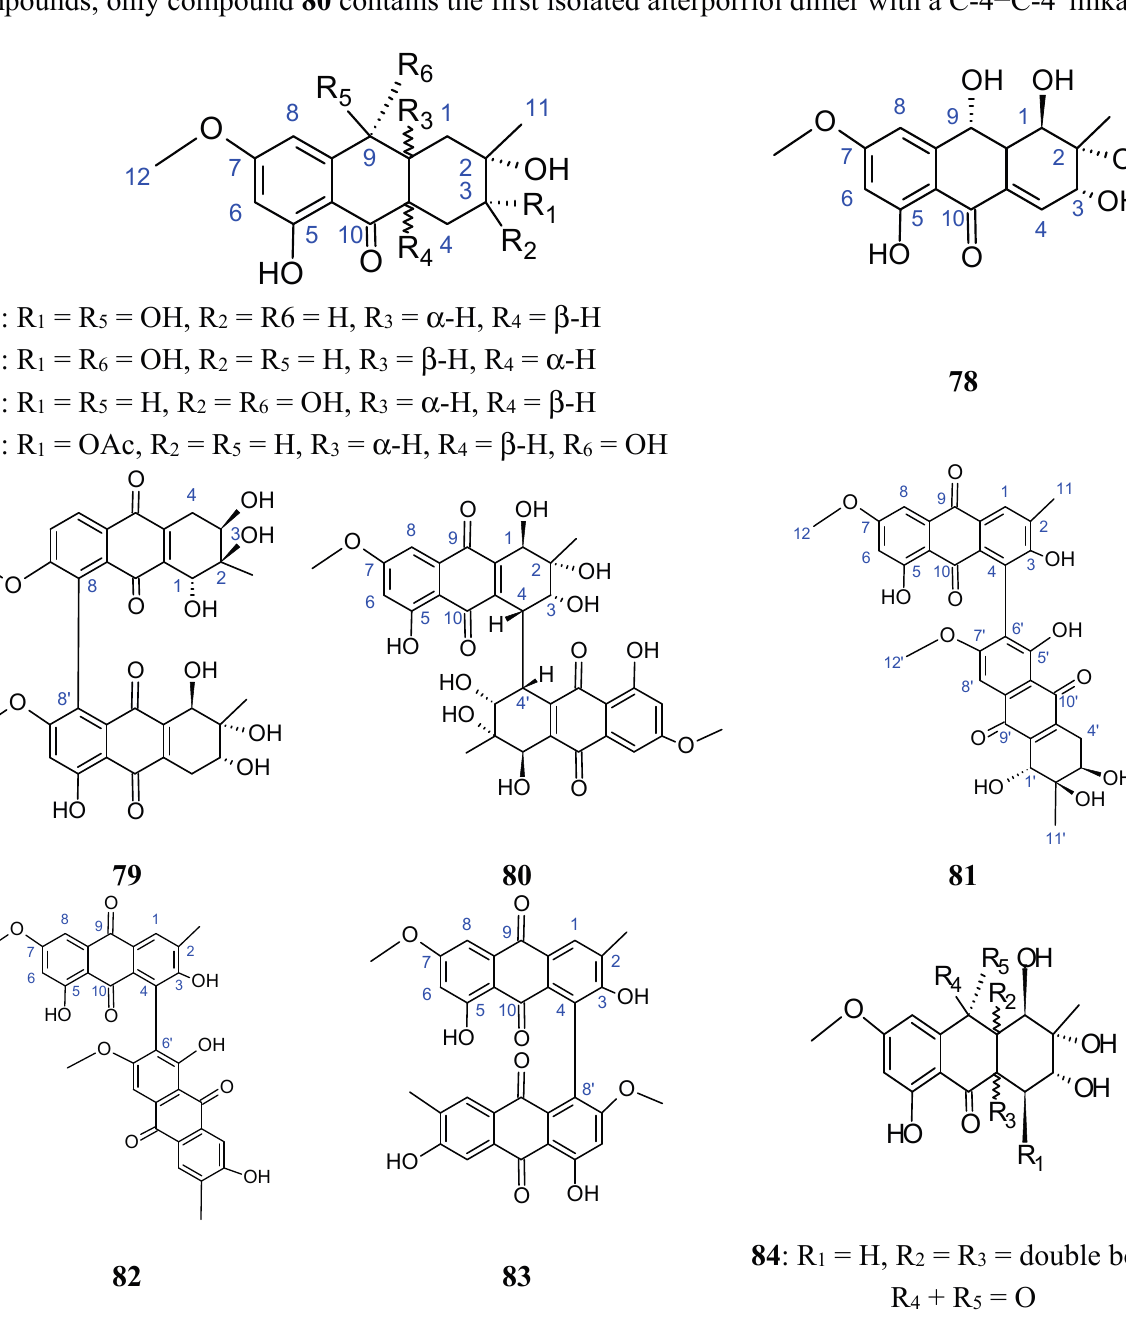
Figure 30. Hydroanthraquinones and anthraquinones dimers ( 74 – 84